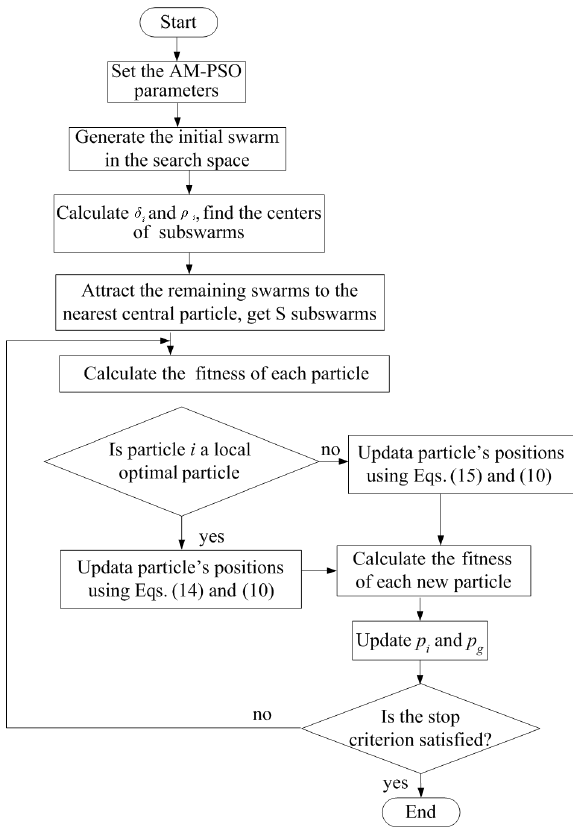
Figure 3. Flowchart of the AM-PSO algorithm.